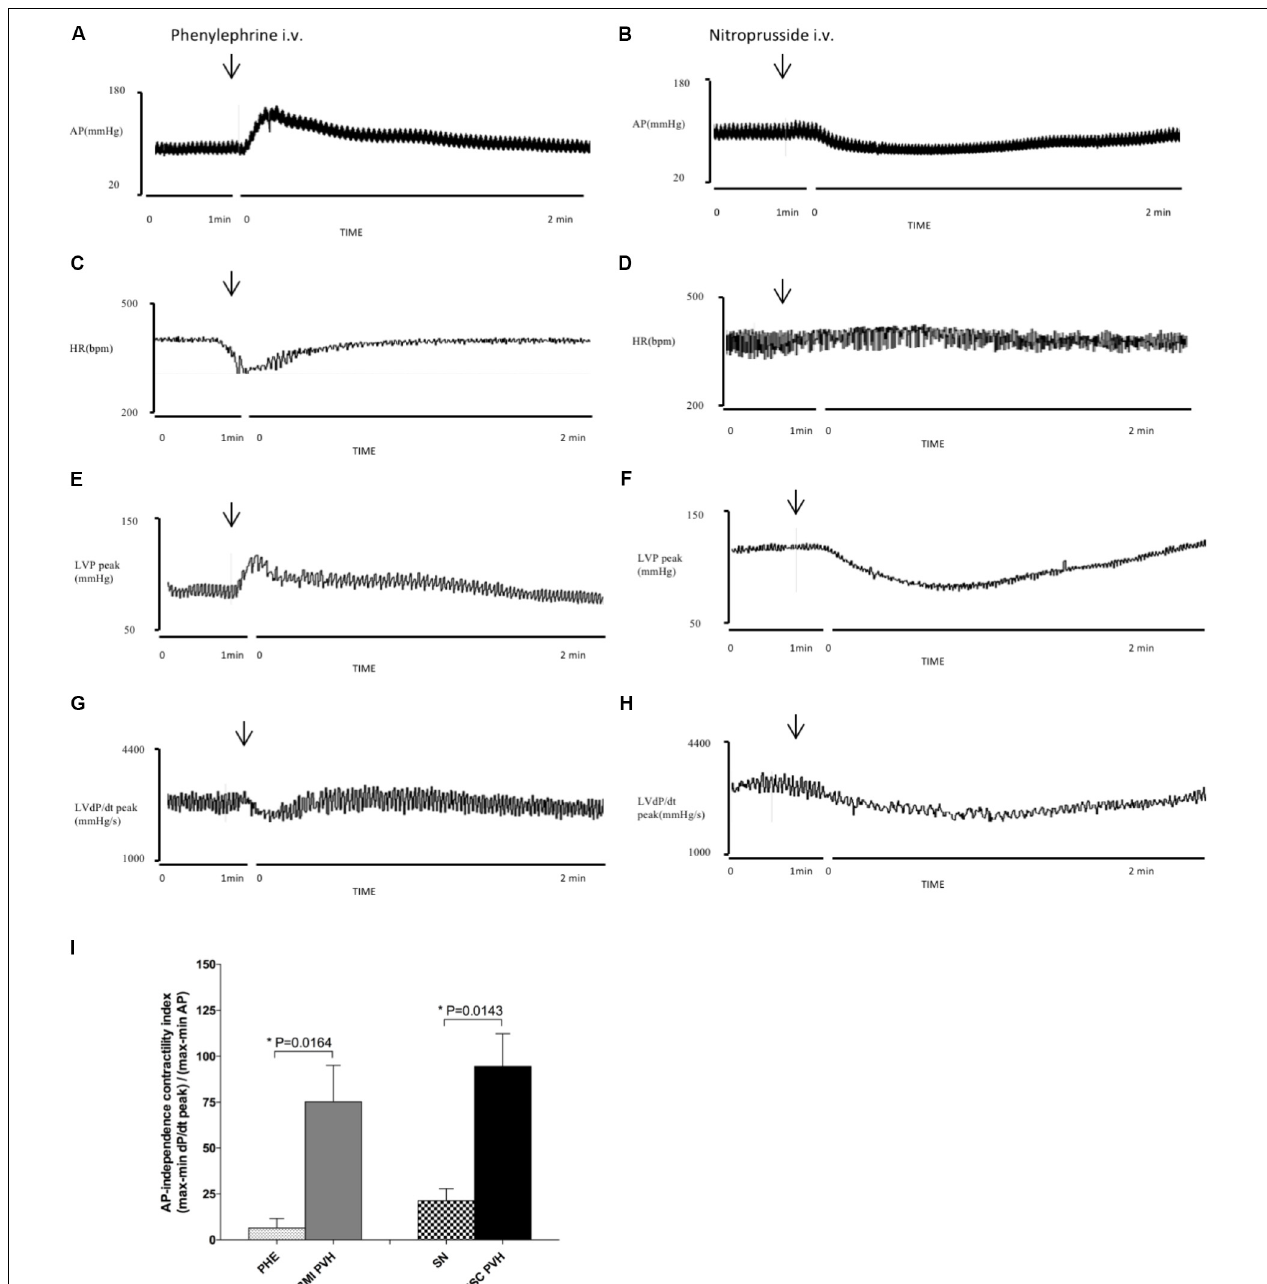
FIGURE 8 | Left column – Chart records illustrating the effects of i.v. injection of phenylephrine on MAP (A) , HR (C) , LVP peak (E) , and LVdP/dt peak (G) . Right column – Records illustrates the effects of i.v. sodium nitroprusside injection on MAP (B) , HR (D) , LVP peak (F), and LVdP/dt peak (H) . Values refer to the means collected in the basal period (2 min before the central injection), and at the maximum point of response to i.v. injections. (I) AP-independence contractility index (for details, see “Materials and Methods”). n =